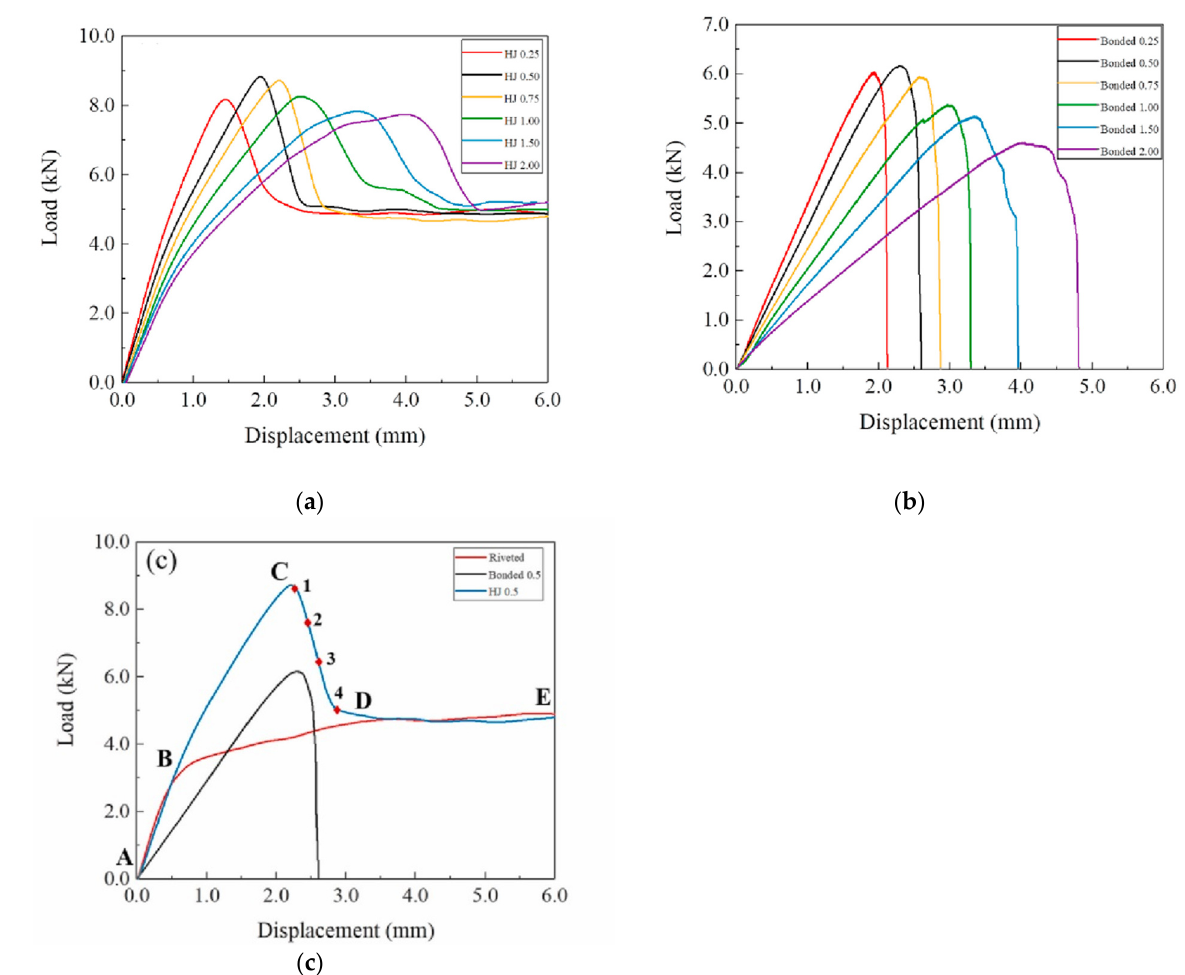
Figure 6. Load ‐ displacement curves of HJs ( a ), bonded joints ( b ) and ( c ) the comparison of three types of joints [63].